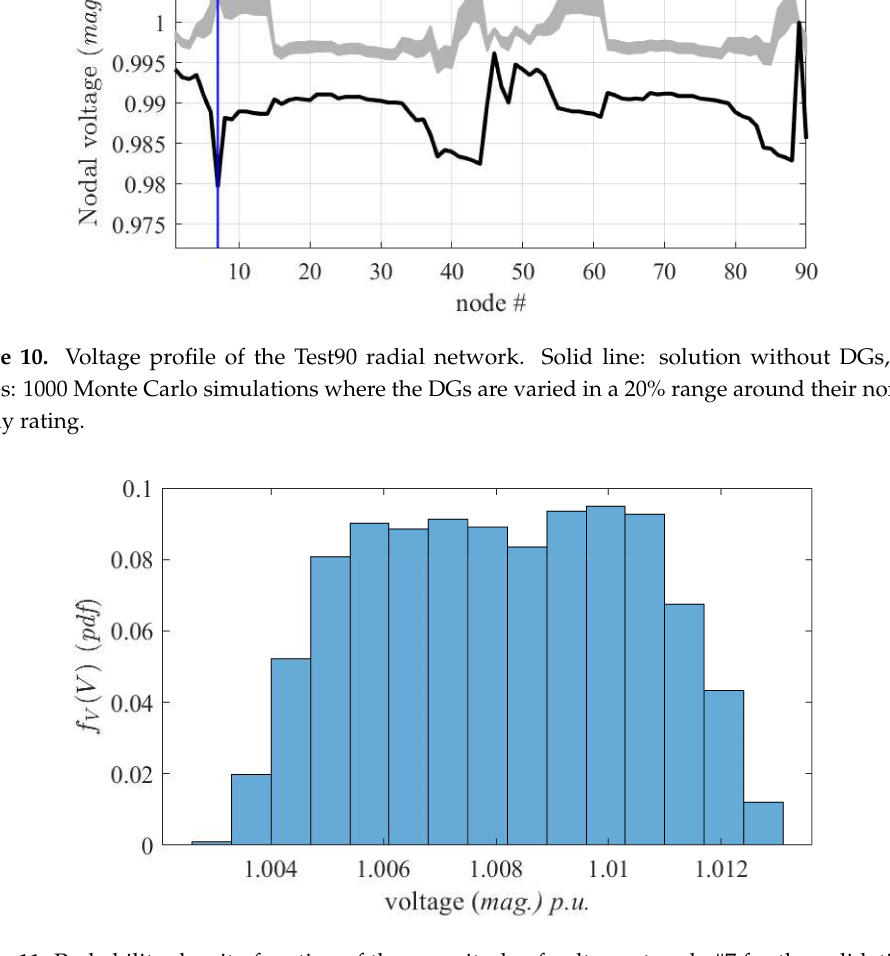
Figure 11. Probability density function of the magnitude of voltage at node #7 for the validation of Figure 10 (see the vertical